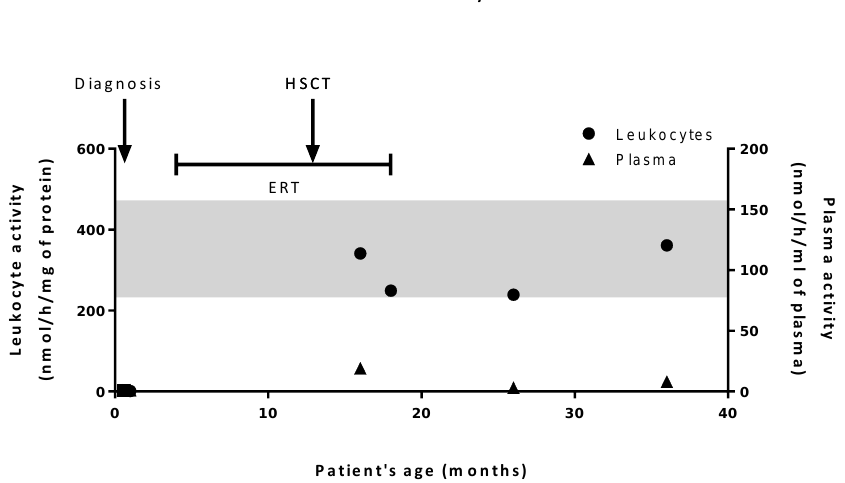
Figure 2. β-glucuronidase (GUSB) activities in patient’s leukocytes and plasma. GUSB activity was measured in patient’s plasma and leukocyte lysates at diagnosis and after hematopoietic stem cell transplantation (HSCT). Activities in leukocytes and plasma are expressed as nmol/h/mg protein and nmol/h/mL, respectively. The shaded band corresponds to the range of control values.